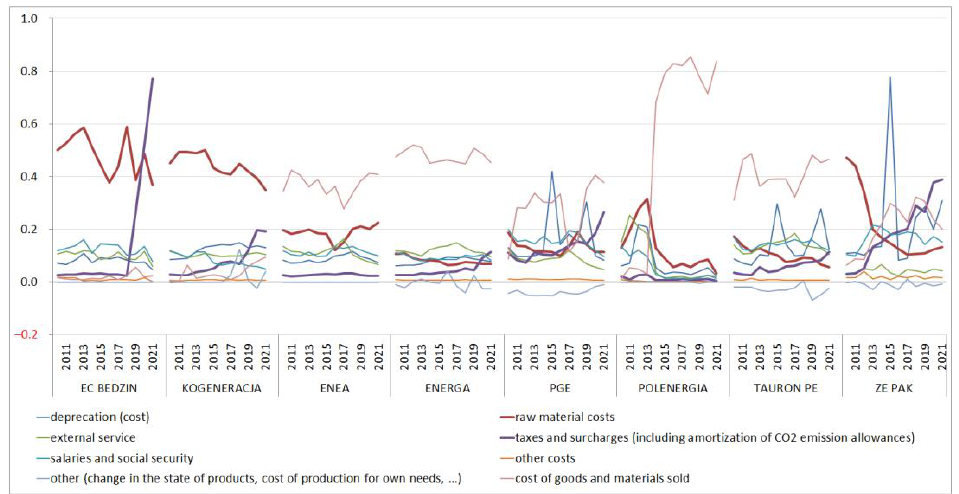
Figure 7. Cost level indicators for individual costs by type in surveyed energy companies (given cost by type/sales revenues). Source: own elaboration.